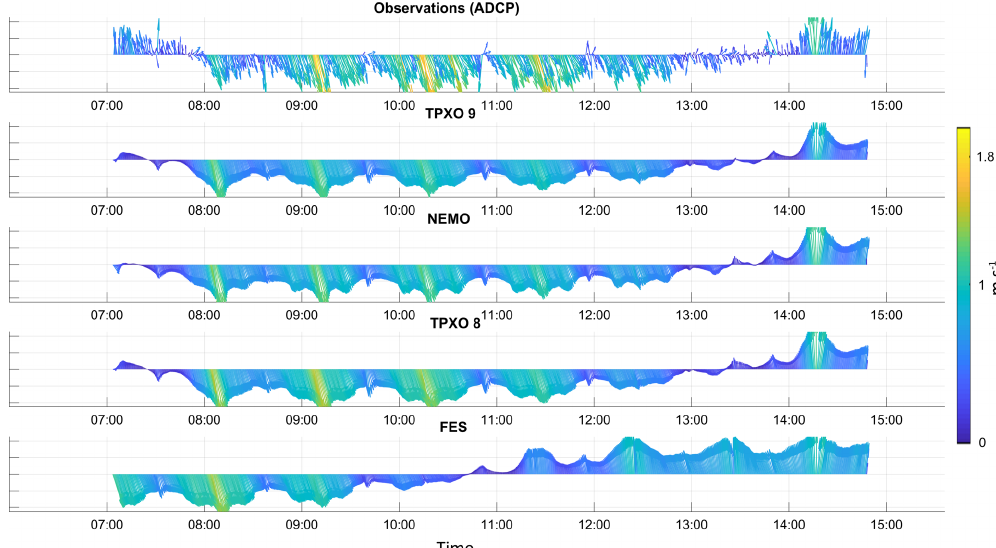
Figure 2. The observed and modelled depth-averaged velocities on 29 May 2018. The coloured arrows indicate the current magnitude (ms − 1 ); arrow directions indicate the current